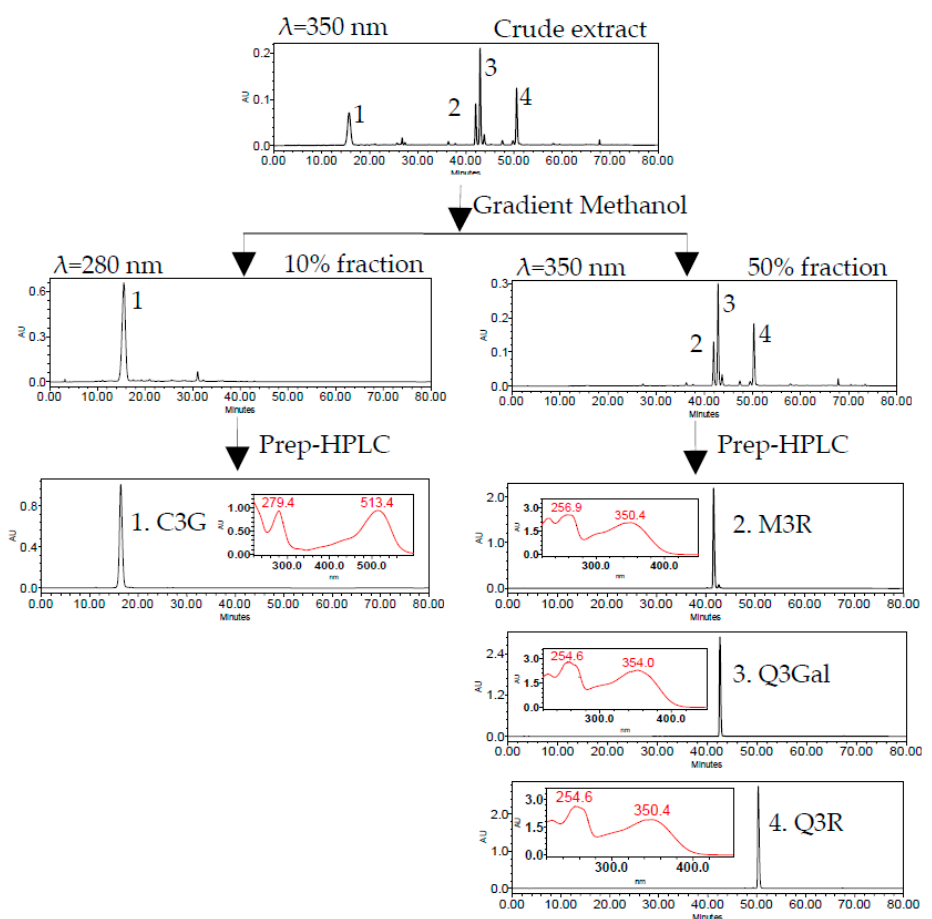
Figure 3. HPLC chromatogram of SPE column and semi-preparative HPLC (Prep-HPLC) purification procedure.